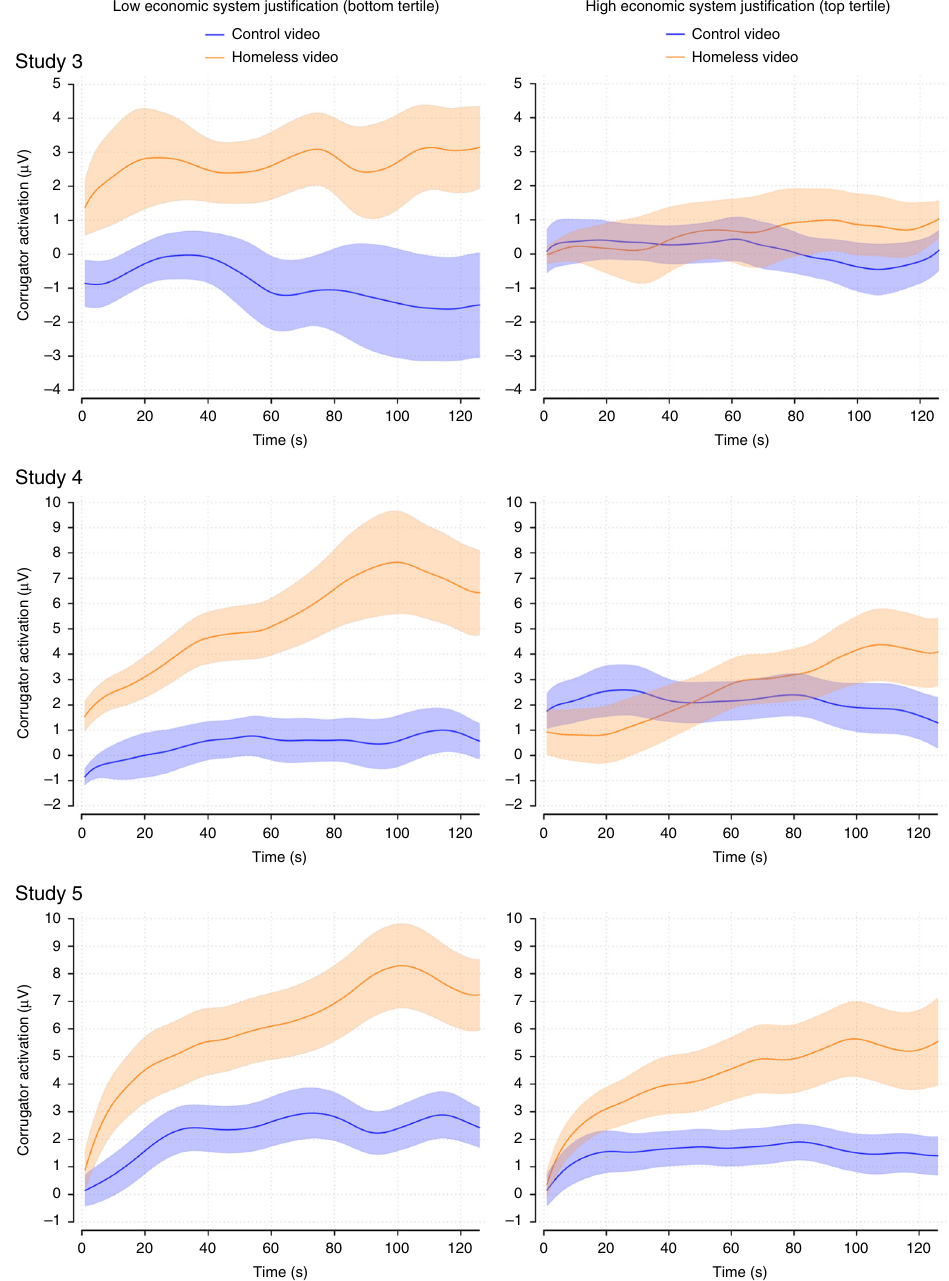
Fig. 1 Economic system justi fi cation predicts muted corrugator supercilii activity during depictions of people experiencing homelessness. The y-axis re fl ects activation relative to baseline. Colored bands indicate ±1 SE. LOWESS smoothing